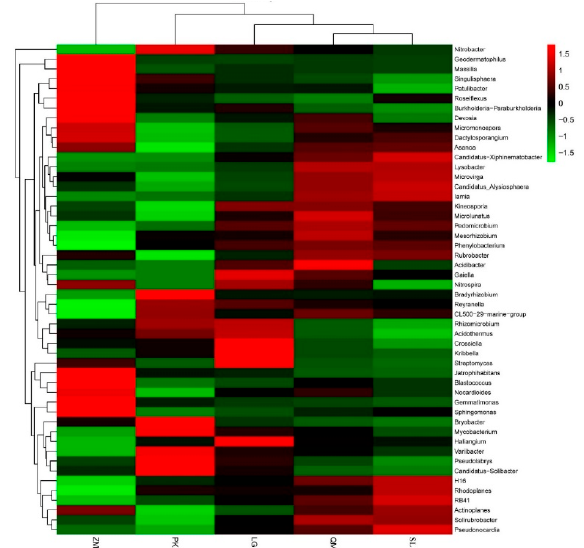
Figure 4. Heat map and hierarchical cluster analysis based on the relative abundances of the top 50 genera identified in the bacterial communities of the soils with different land use types. Different colors indicate the relative abundance of species in the individual samples. The samples are grouped according to their similarity, and the clustering results are arranged horizontally. Red represents the genus with higher abundance in the corresponding sample, whereas green represents the genus with lower abundance. QM; Quercus mongolica ; LG: Larix gmelinii ; PK: Pinus koraiensis ; SL: Shrubland; ZM: Zea mays .